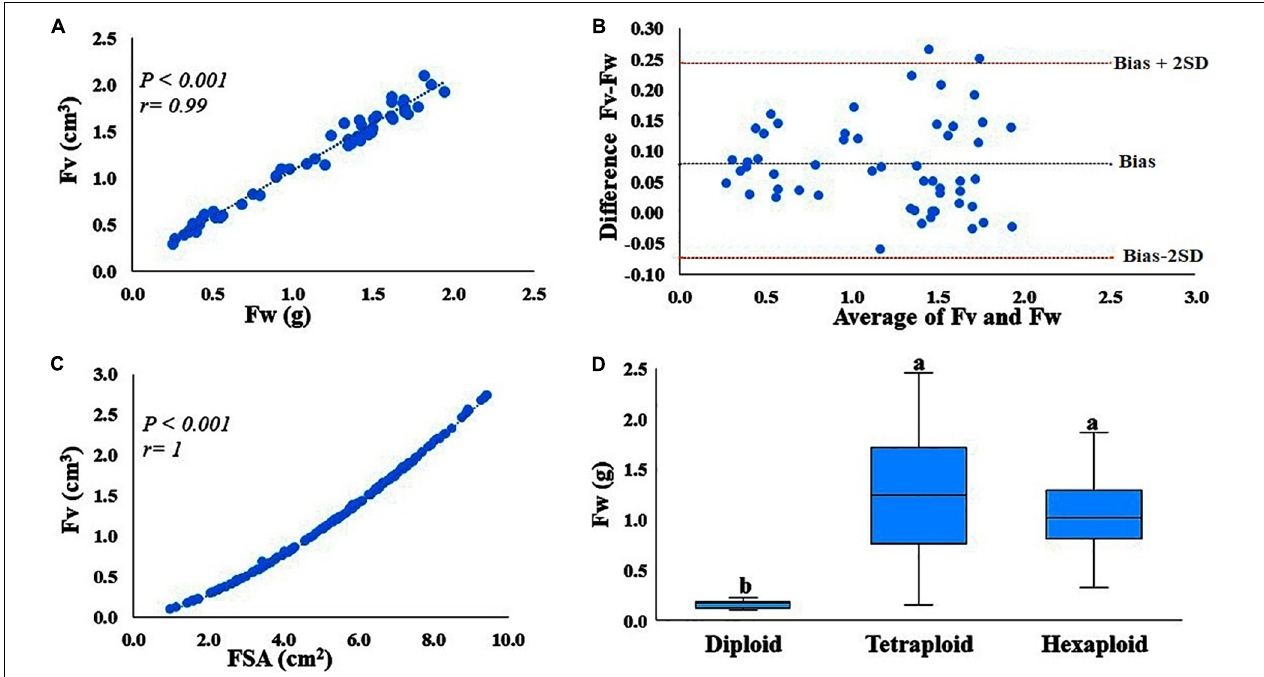
FIGURE 1 | Correlation and agreement between fruit volume (Fv) and fruit weight (Fw), and Fw variations within and between ploidy level. (A) Correlation between fruit volume (cm 3 ) measured using GiNA (image-based phenotyping) and fruit weight (g). (B) Agreement between the two measurements, Fv (cm 3 ) estimated by GiNA and Fw (g). Bias is the mean of the differences between the two measurements, whereas bias-2SD and bias + 2SD are the lower and upper limits of the interval agreement, respectively. SD is the standard deviation of the mean of the differences. (C) Correlation between the two fruit parameters, fruit surface area (cm 2 ) and fruit volume (cm 3 ) as estimated by GiNA (image-based phenotying). (D) Fw variation between and within ploidy level.